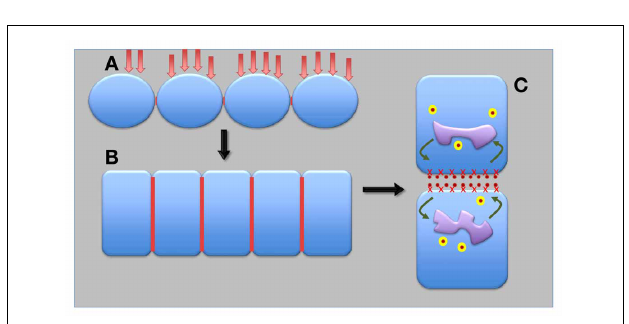
FIGURE 4 | Possible scenario for evolution of epithelial and auxin transporting plant synapses. Under repeated pathogen attacks and with progressive exposures of ancient terrestrial plants to dry environments, ancient surface epithel-like tissue (A) developed into the contemporary epidermis and endodermis plant epithels (B) . Finally, auxin-transporting synapses evolved from epithelial synapses (C) . Red lines show synaptic cell–cell adhesion domains; red crosses depict APB1; yellow balls are recycling vesicles; and orange dots represent